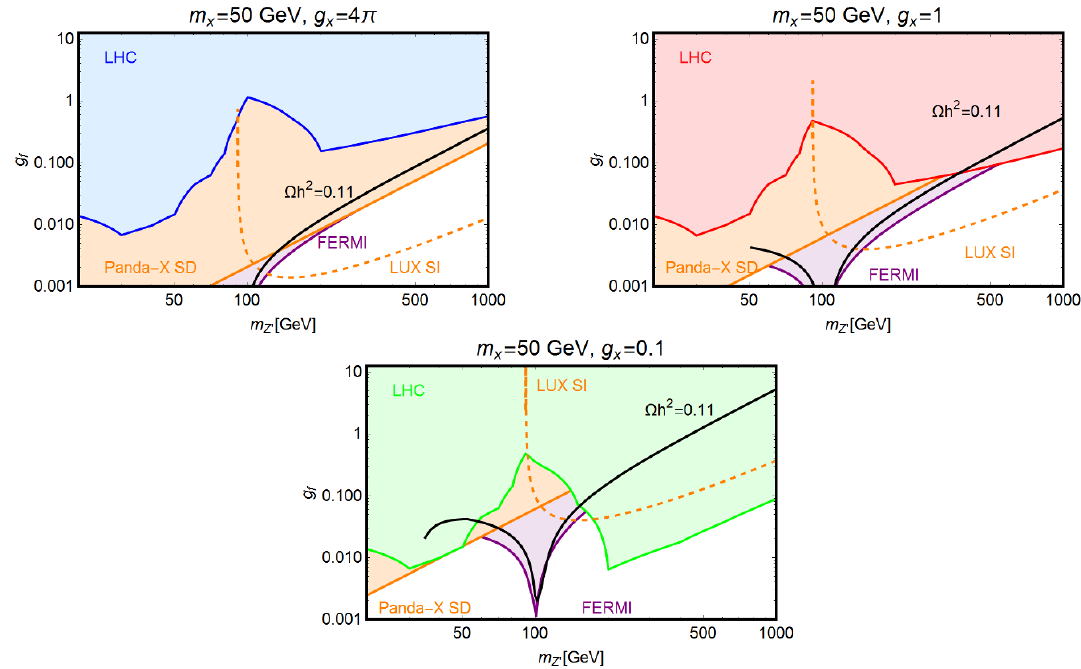
Figure 5 . Results for m (cid:31) = 50 GeV and g (cid:31) = 4 (cid:25); 1 and 0 : 1. Combined upper bounds on the model under study, in the bidimensional plane ( m Z 0 ; g f ) for the assignations of the DM mass m (cid:31) and coupling g (cid:31) reported in the di(cid:11)erent panels. The black lines delimit the correct relic density parameter space. The blue, red and green regions are excluded by LHC data. The orange region represents spin-dependent PANDA-X exclusion region, whereas the dashed curve the spin- independent LUX limit, while in purple FERMI-LAT